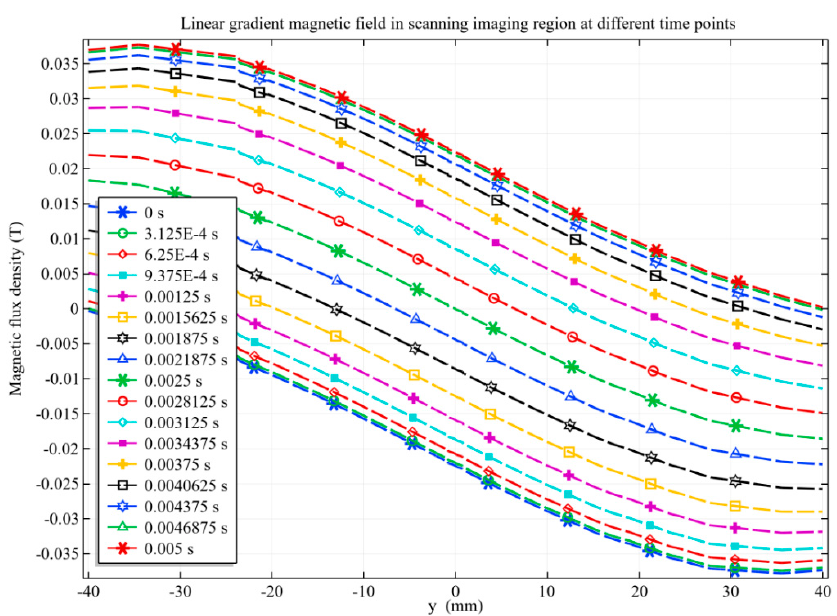
Figure 10. Linear gradient magnetic field distribution at different time points within the range of the